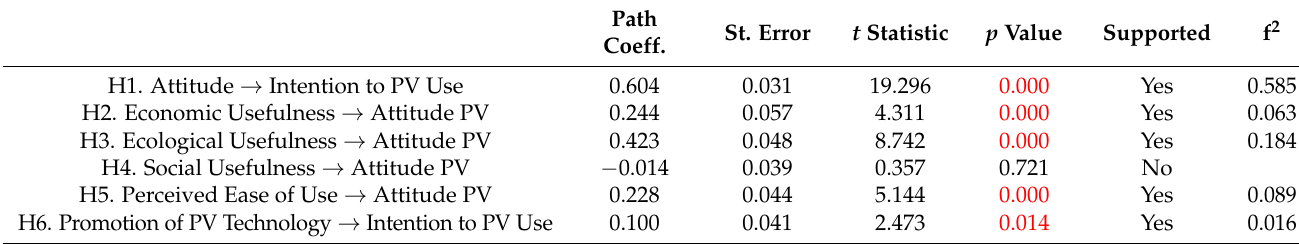
Table 5. Structural model